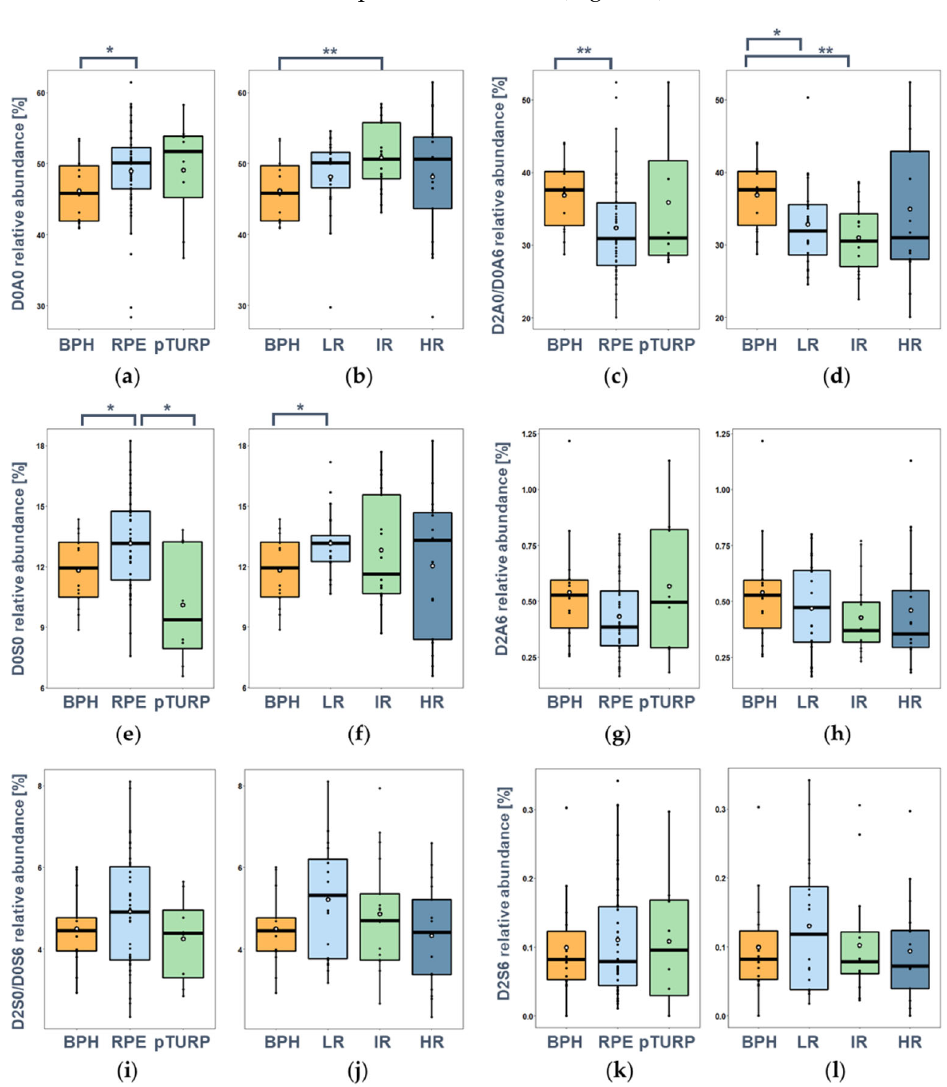
Figure 5. Relative abundance of measured HS disaccharides as a function of the surgery type and the risk stratification based on Gleason scores, respectively: ( a , b ) D0A0; ( c , d ) D2A0/D0A6; ( e , f ) D0S0; ( g , h ) D2A6; ( i , j ) D2S0/D0S6; ( k , l ) D2S6. (*: p < 0.05, **: p < 0.01). See Figure 1 for resolving the GAG structure